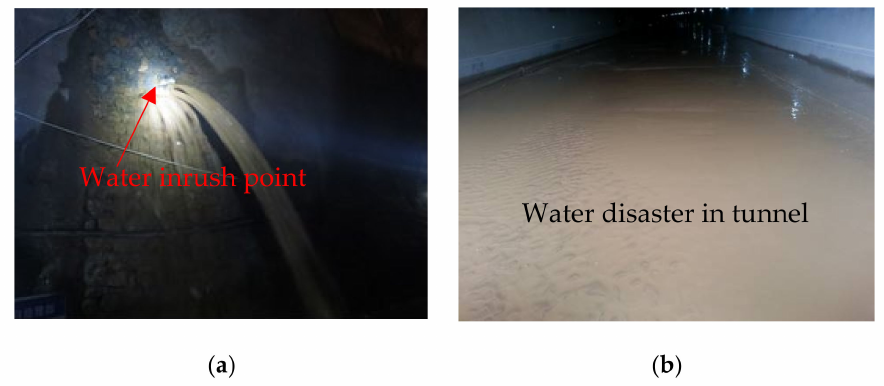
Figure 3. Site condition of water inrush in the Shangjiawan tunnel ( a ) water inrush point; ( b ) water disaster in tunnel.